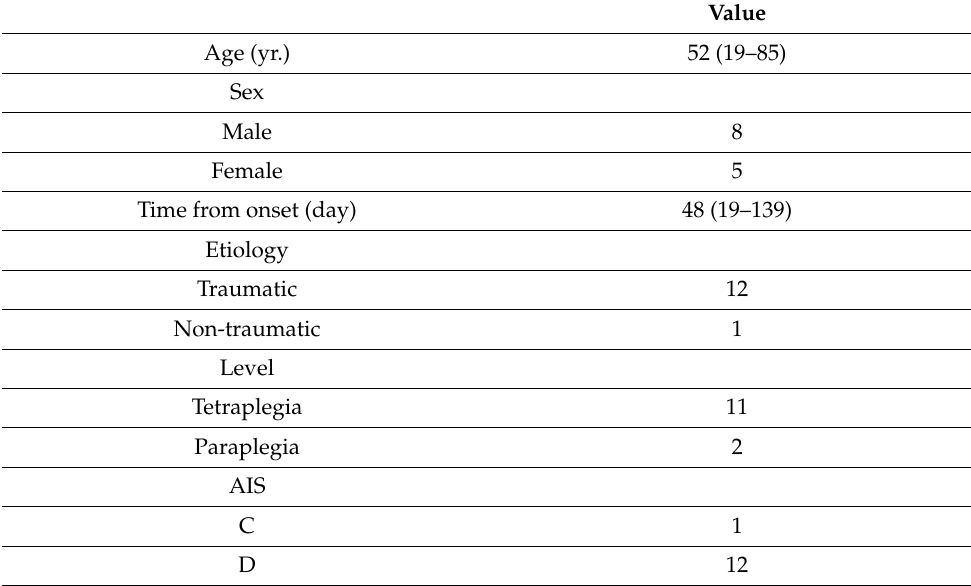
Table 1. Demographic and clinical characteristics (n =